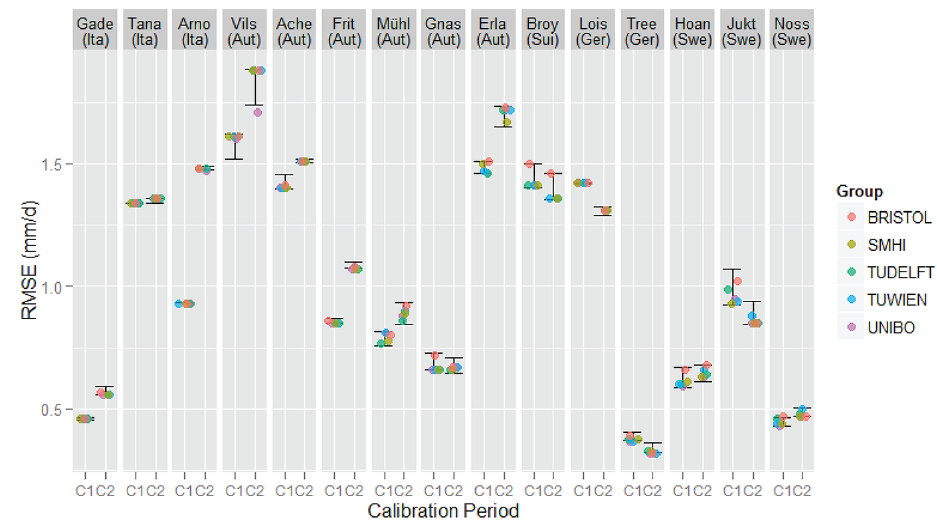
Figure 2. Optimal RMSE of runoff (square root of the objective function) obtained for calibration period 1 and calibration period 2 by each research group for the 15 catchments. The black bars show the range in optimal performance obtained by a single research group (BRISTOL) from 100 calibration runs initiated from different random